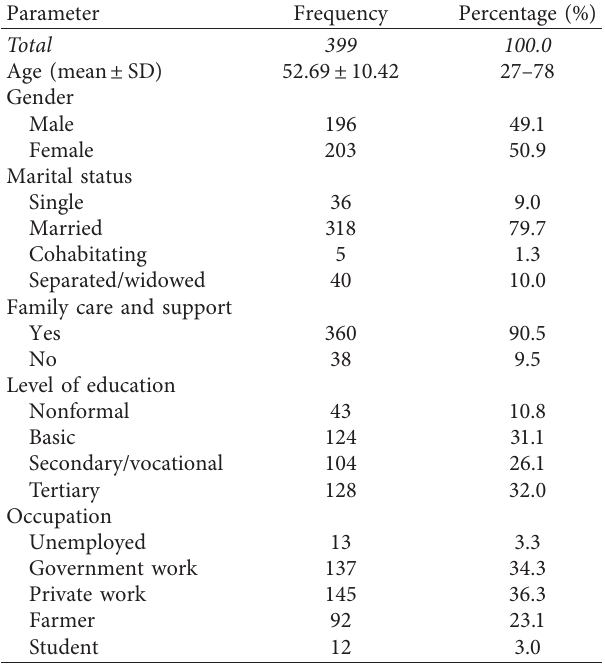
Table 2: Demographic characteristics of